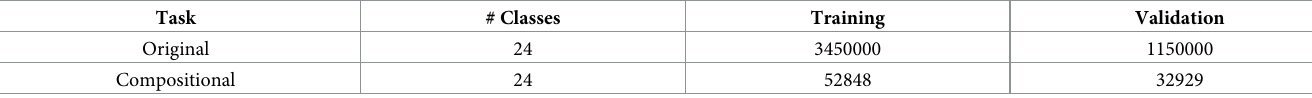
Table 1. Statistics of original action recognition and compositional action recognition on LEMMA.